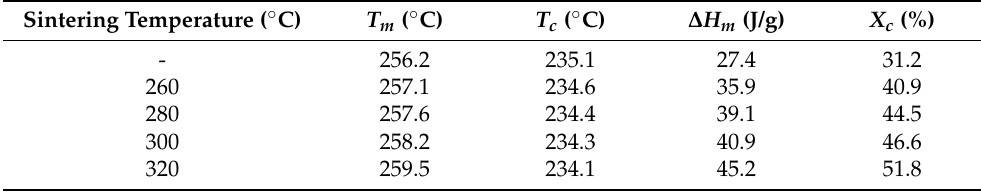
Figure 7. DSC curves of ultrafine fibrous FEP porous membranes at different sintering temperature (FEP/PVA mass ratio: 1:6; a: nascent membrane; b: 260 °C; c: 280 °C; d: 300 °C; e: 320 °C; ( A )-heating curve, ( B )-cooling curve). Table 1. Thermal property of ultrafine fibrous FEP porous membranes by DSC.